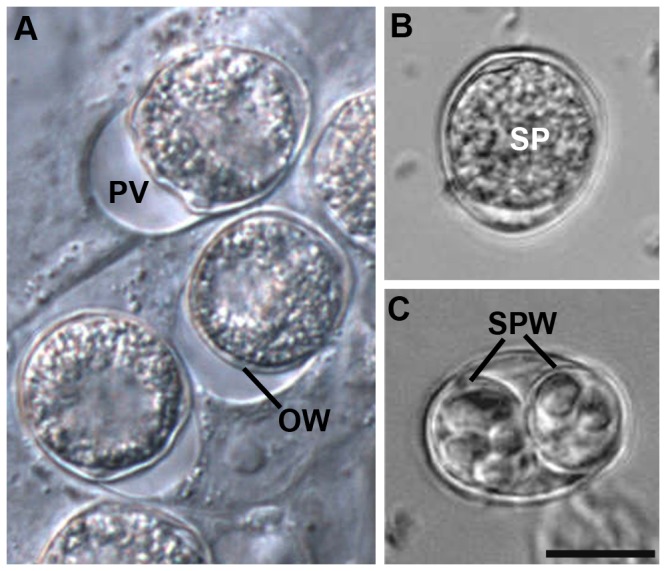
Oocysts of

I

. suis
 in the in vitro culture.(A) intracellular oocysts with a distinct parasitophorous vacuole (PV) and an already developed oocysts wall (OW) on dpi 13; (B) free unsporulated oocyst containing the sporont (SP); (C) sporulated oocyst 5 days after harvest from cell culture and incubation in tap water at room temperature with developed sporocyst walls (SPW) containing sporozoites; dpi, days post infection; bar = 10 µm.